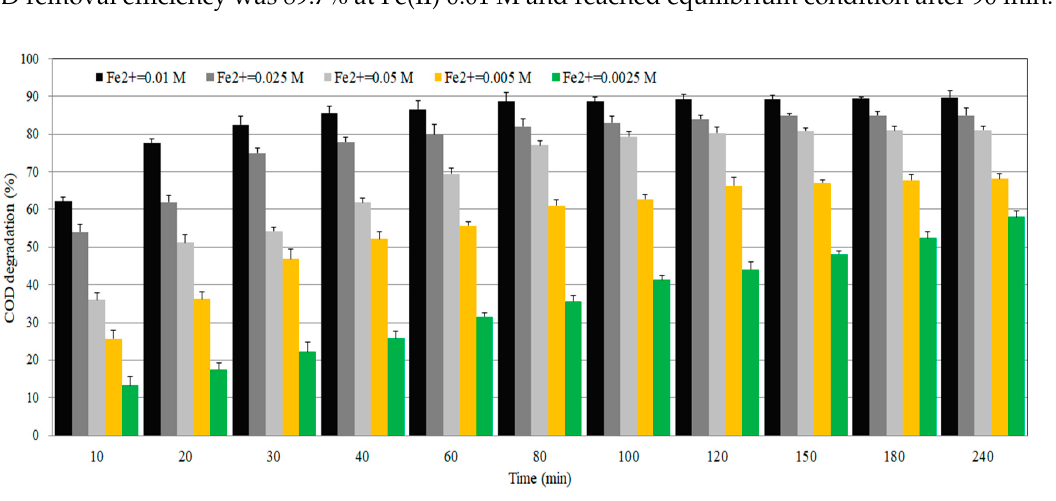
Figure 4. E ff ect of Fe 2 + dosage on COD removal in photo-assisted Fenton oxidation (pH = 3.5, Figure 4. Effect of Fe 2+ dosage on COD removal in photo-assisted Fenton oxidation (pH = 3.5, H 2 O 2 = H 2 O 2 = 0.1 M, UV 254 intensity = 3.524 mW / cm 2 0.1 M, UV 254 intensity = 3.524 mW/cm 2 ).